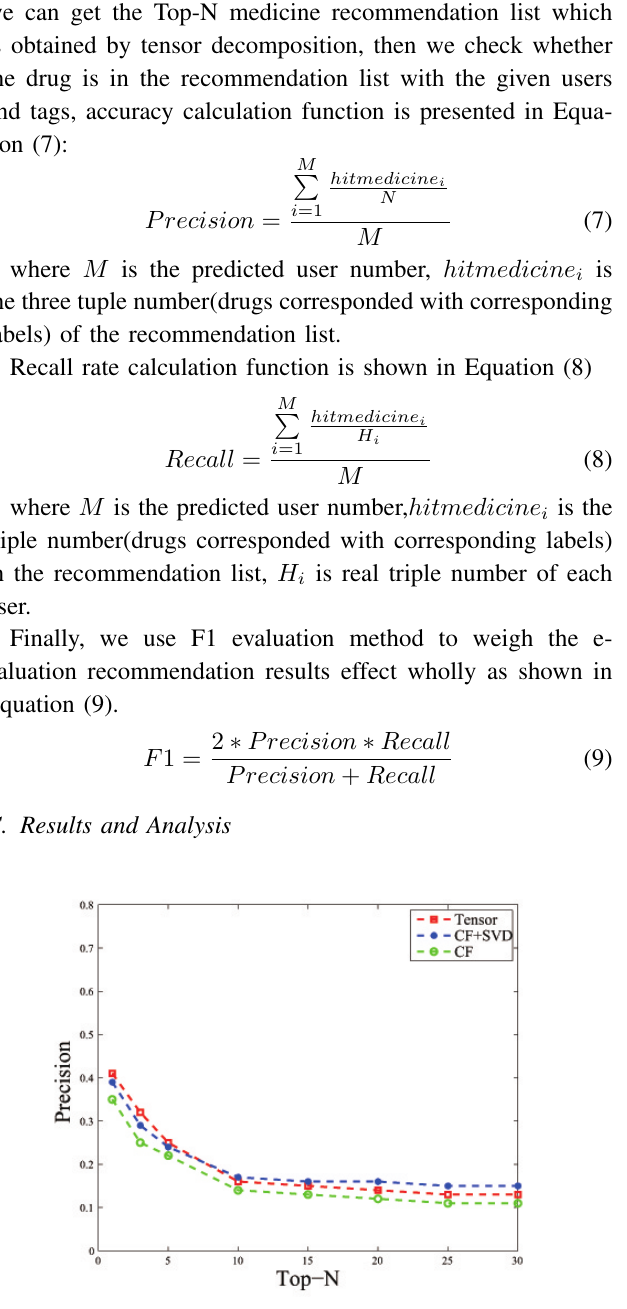
Fig. 5. The accurate rate of Tensor and